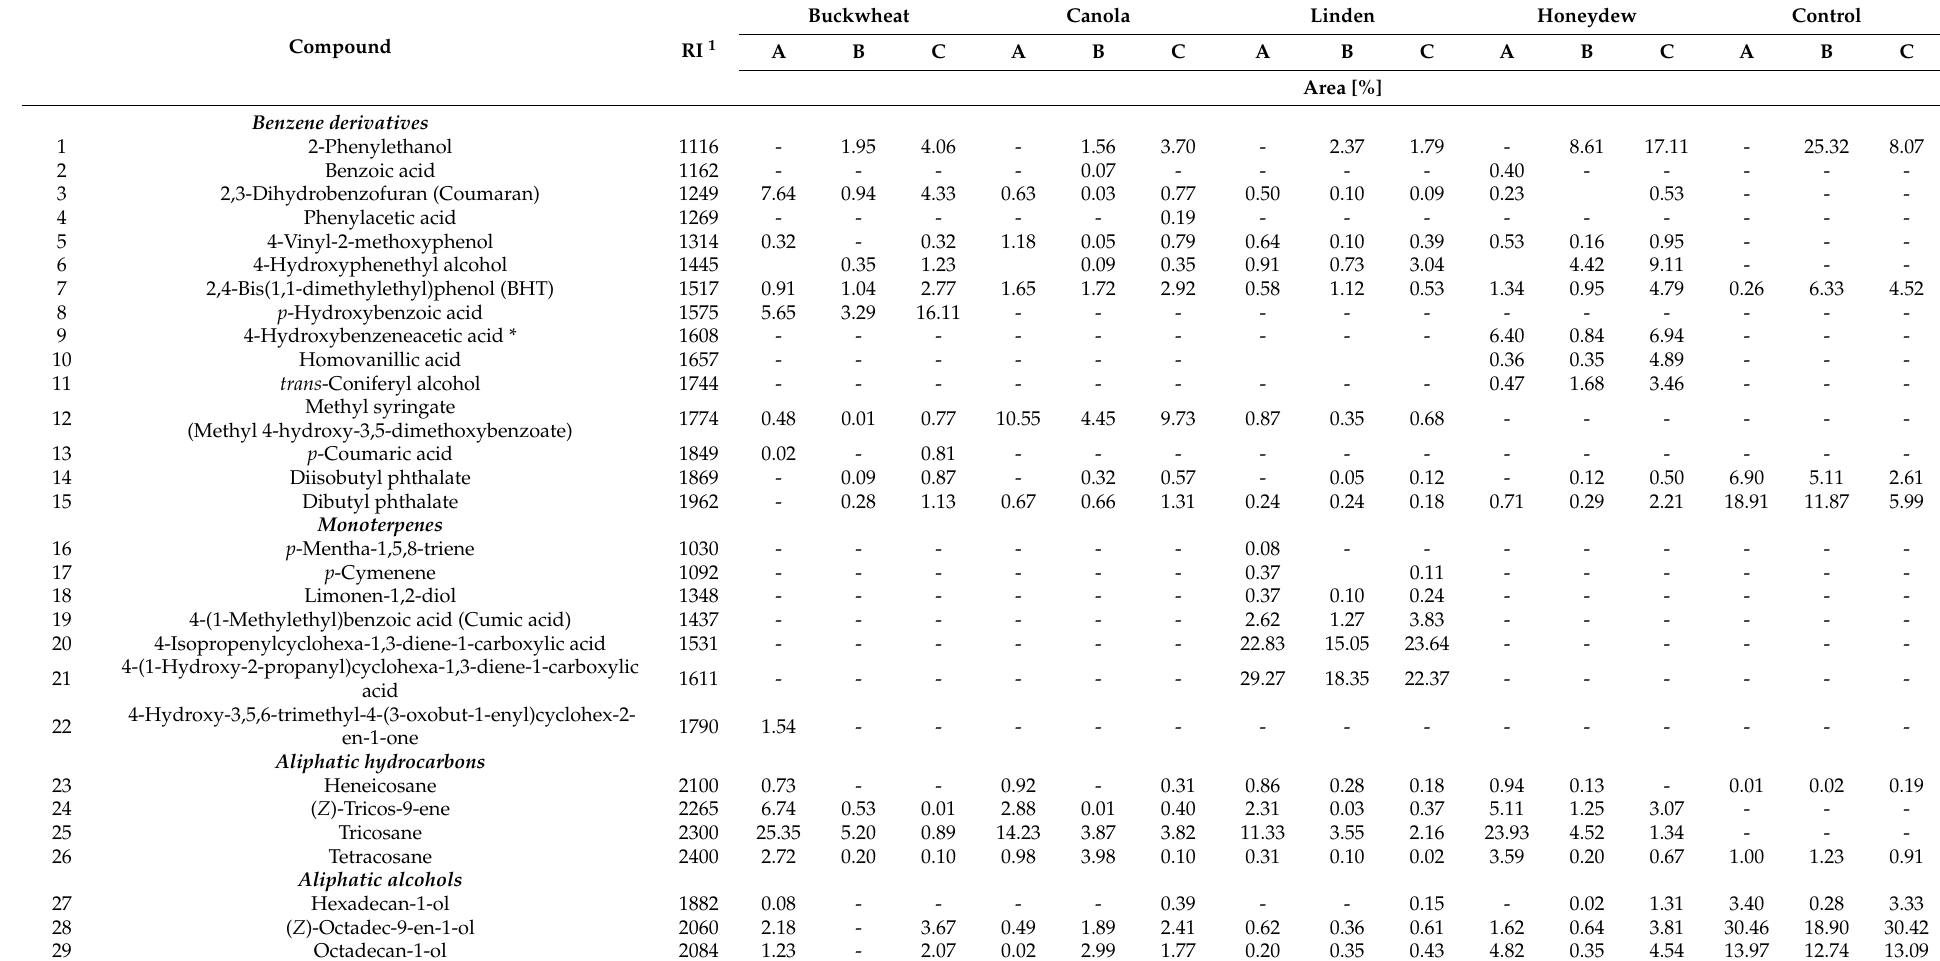
Table 2. Comparison of the DHLLE extract profiles of meads and related unifloral